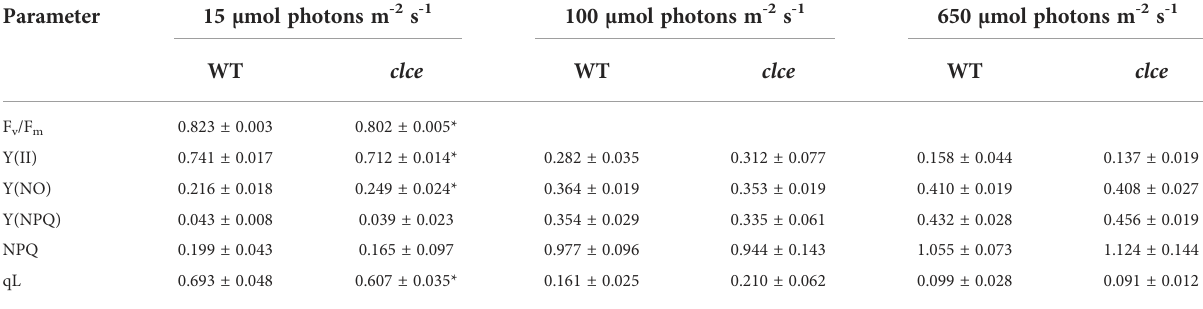
TABLE 1 Chlorophyll fl uorescence parameters of plants grown in light-limiting